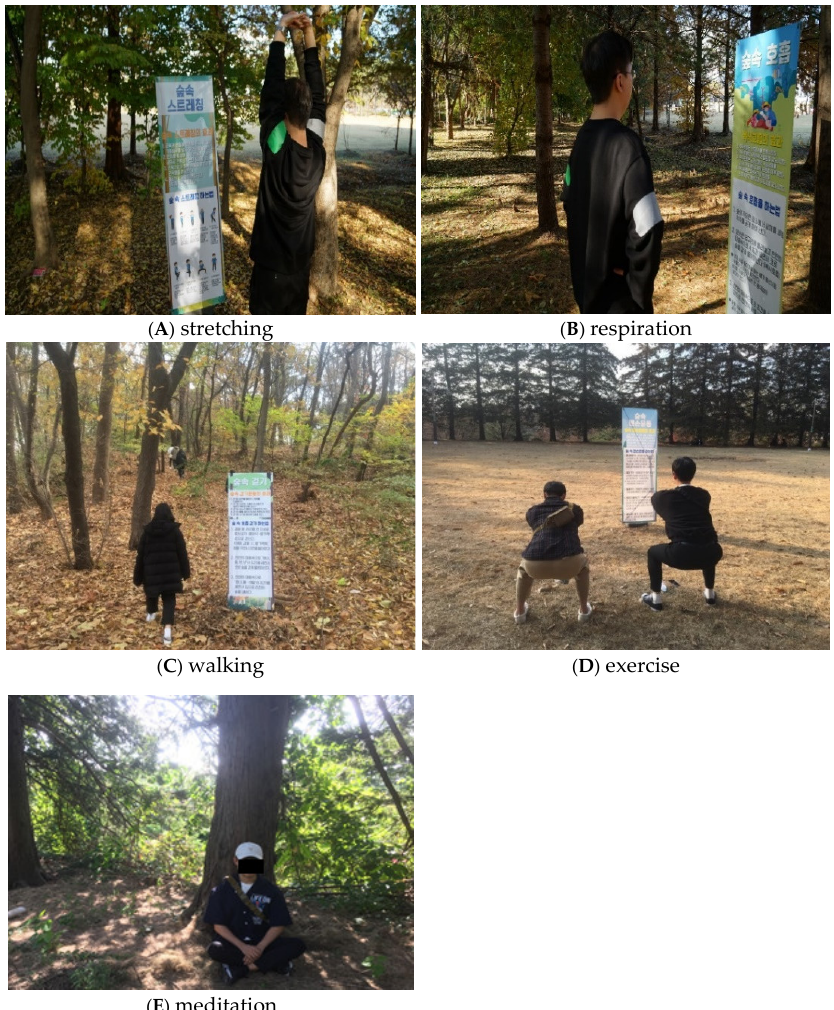
Figure 2. Campus forest activities